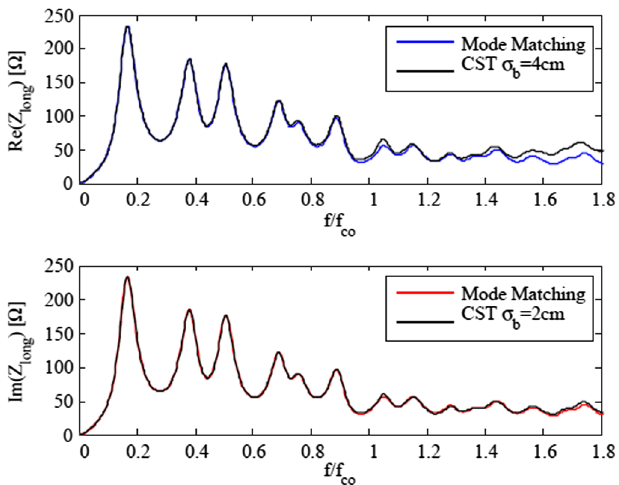
FIG. 5 (color online). Comparison of the mode matching method (full lines) with the standard thick wall formula (dashed lines) for conductivities from σ ¼ 10 S = m to σ ¼ 10 3 S = m. Frequency f is normalized to the cutoff frequency f matching modes: S ¼ 20 , P ¼ 10 .